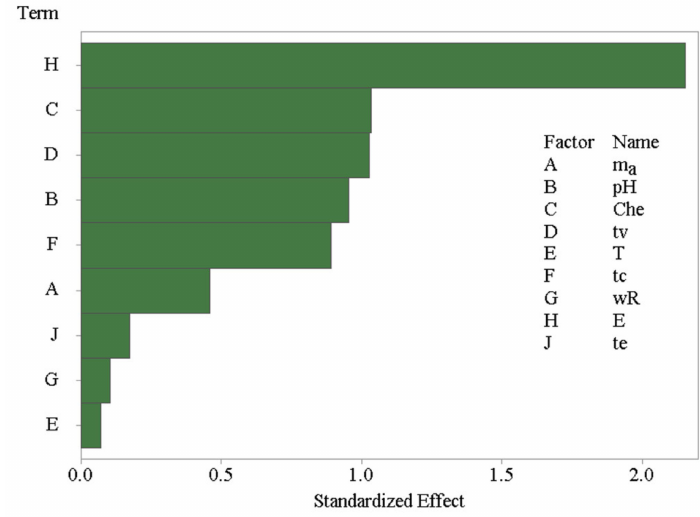
Figure 3. Pareto plot for the Plackett–Burman screening